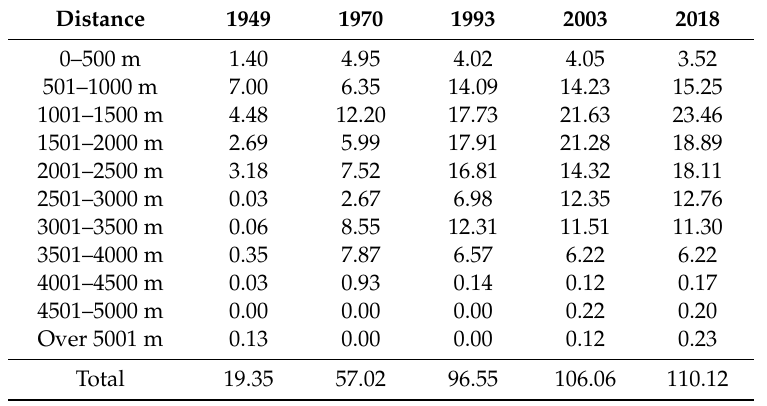
Table8. Theareasofindustrialandtechnicalfacilitiesrelatedtorailroadstationaccessibility(inhectares).